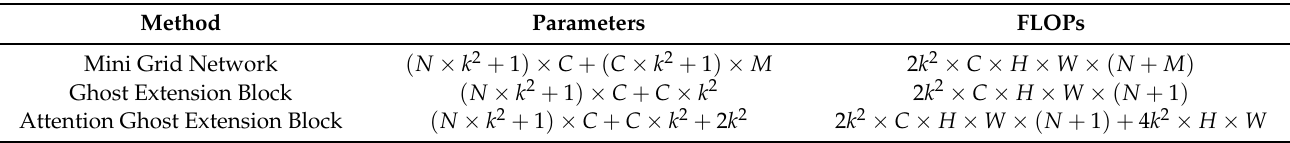
Table 1. Comparison of mini grid network, ghost extension block, and attention ghost extension block.